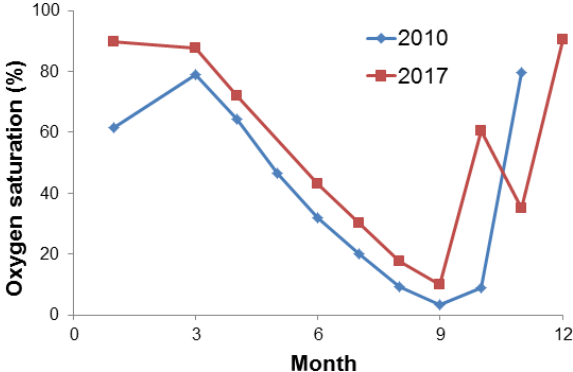
Figure 6. Variations of bottom O 2 saturation in 2010 (blue) and 2017